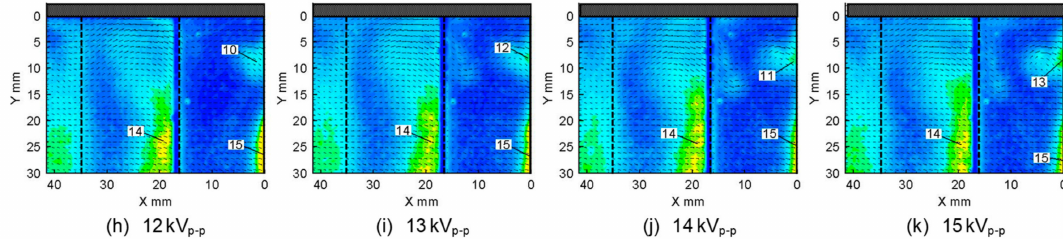
Figure 18. Turbulence intensity distributions at the outlet of the linear turbine cascade at various input voltages ( U FS , out = 4.7 m / s).